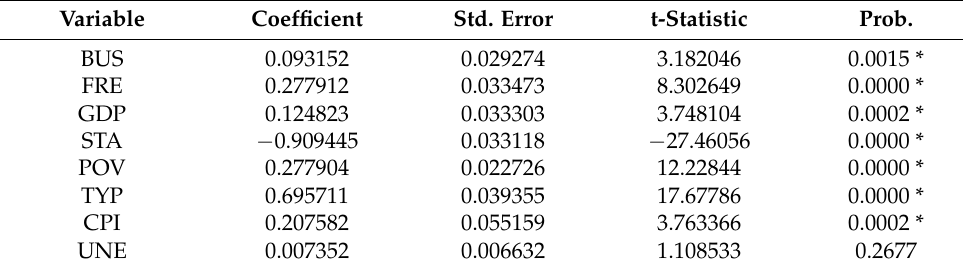
Table 1. Common effect (PLS)—pooled panel data estimation.